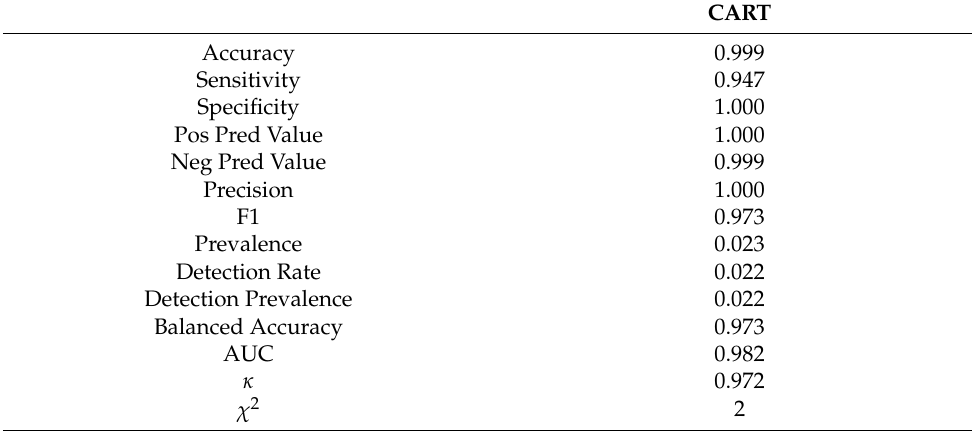
Table 4. Table of coefficients obtained for the reconstruction shown in Figure